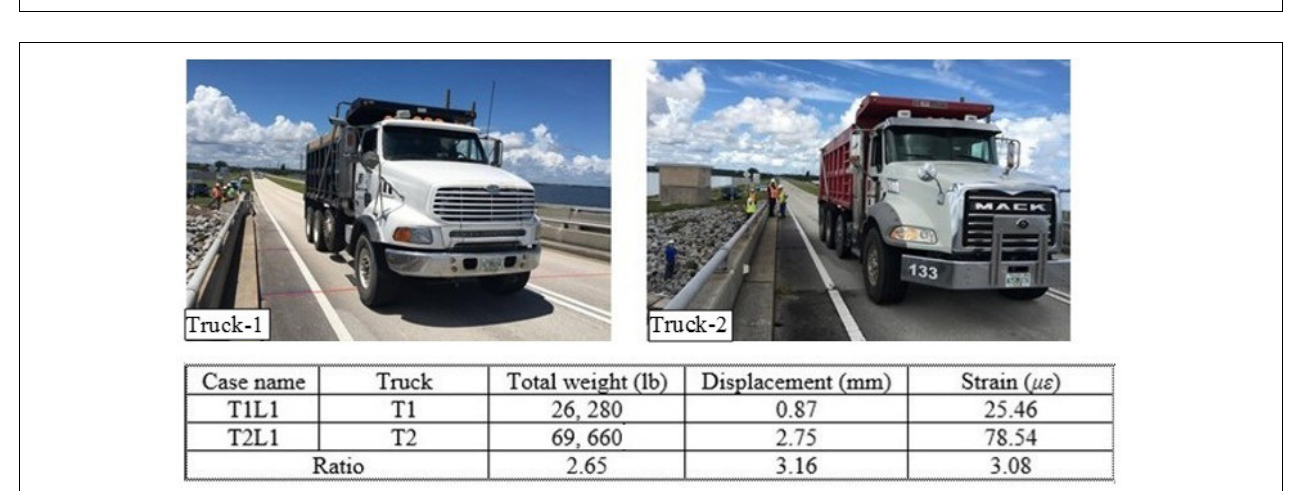
FIGURE 6 | Trucks loaded the left lane Truck-1 and